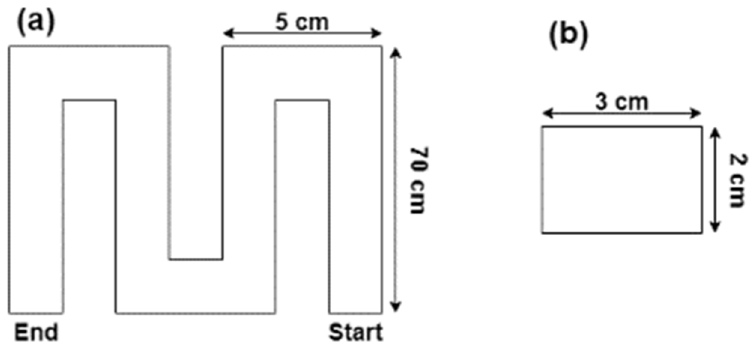
Figure 4. ( a ) Printing path of single layer filament print test. ( b ) Cross-sectional area of the theoretical deposited layer.